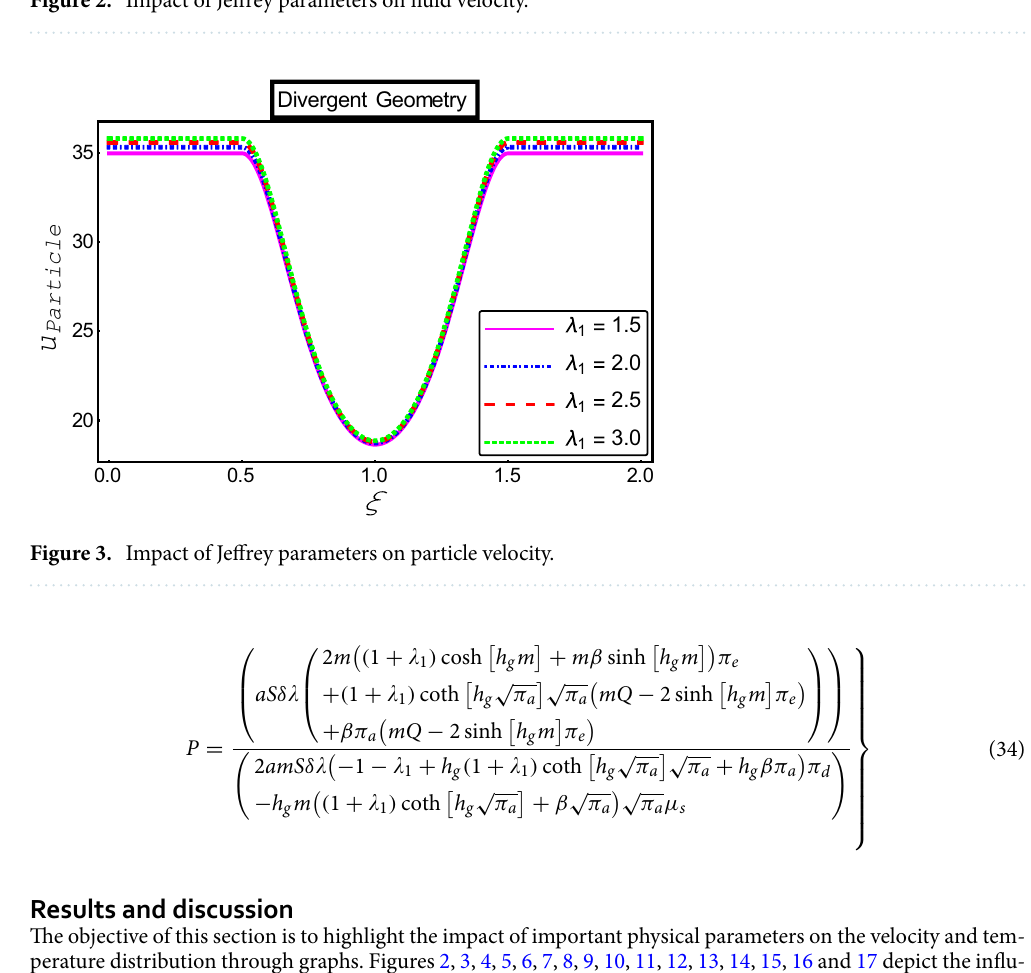
Figure 2. Impact of Jeffrey parameters on fluid velocity.